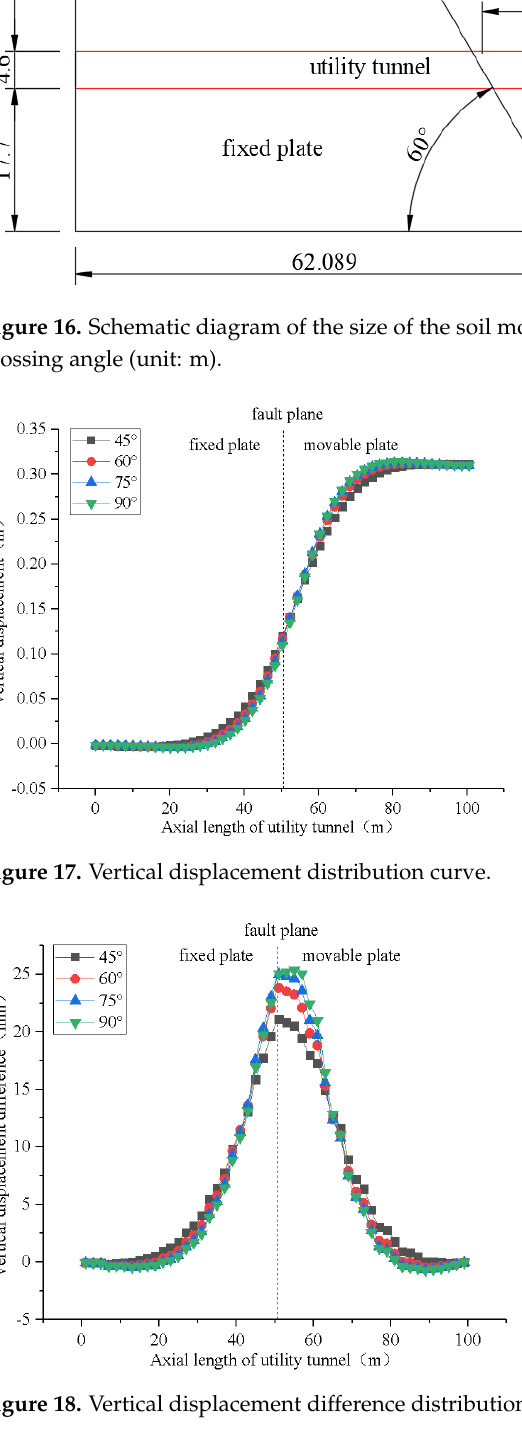
Figure 18. Vertical displacement difference distribution curve.